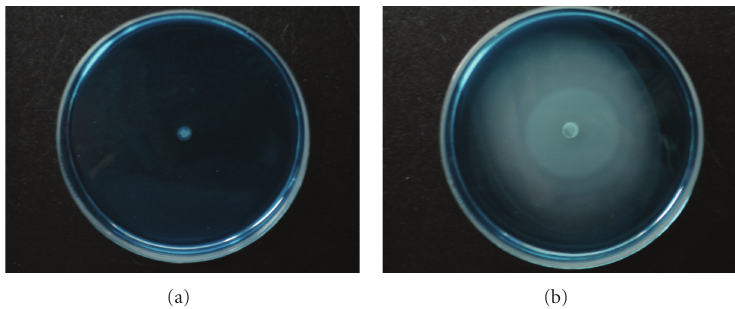
Figure 3: Salmonella enterica subsp. enterica serovar Typhimurium LB 5010 and the stbC mutant grown on MSRV agar medium. (a) Salmonella enterica subsp. enterica serovar Typhimurium LB5010 did not exhibit any “halo” appearance on the agar surface. (b) a gray- white zone was observed extending from the inoculated drop of the stbC